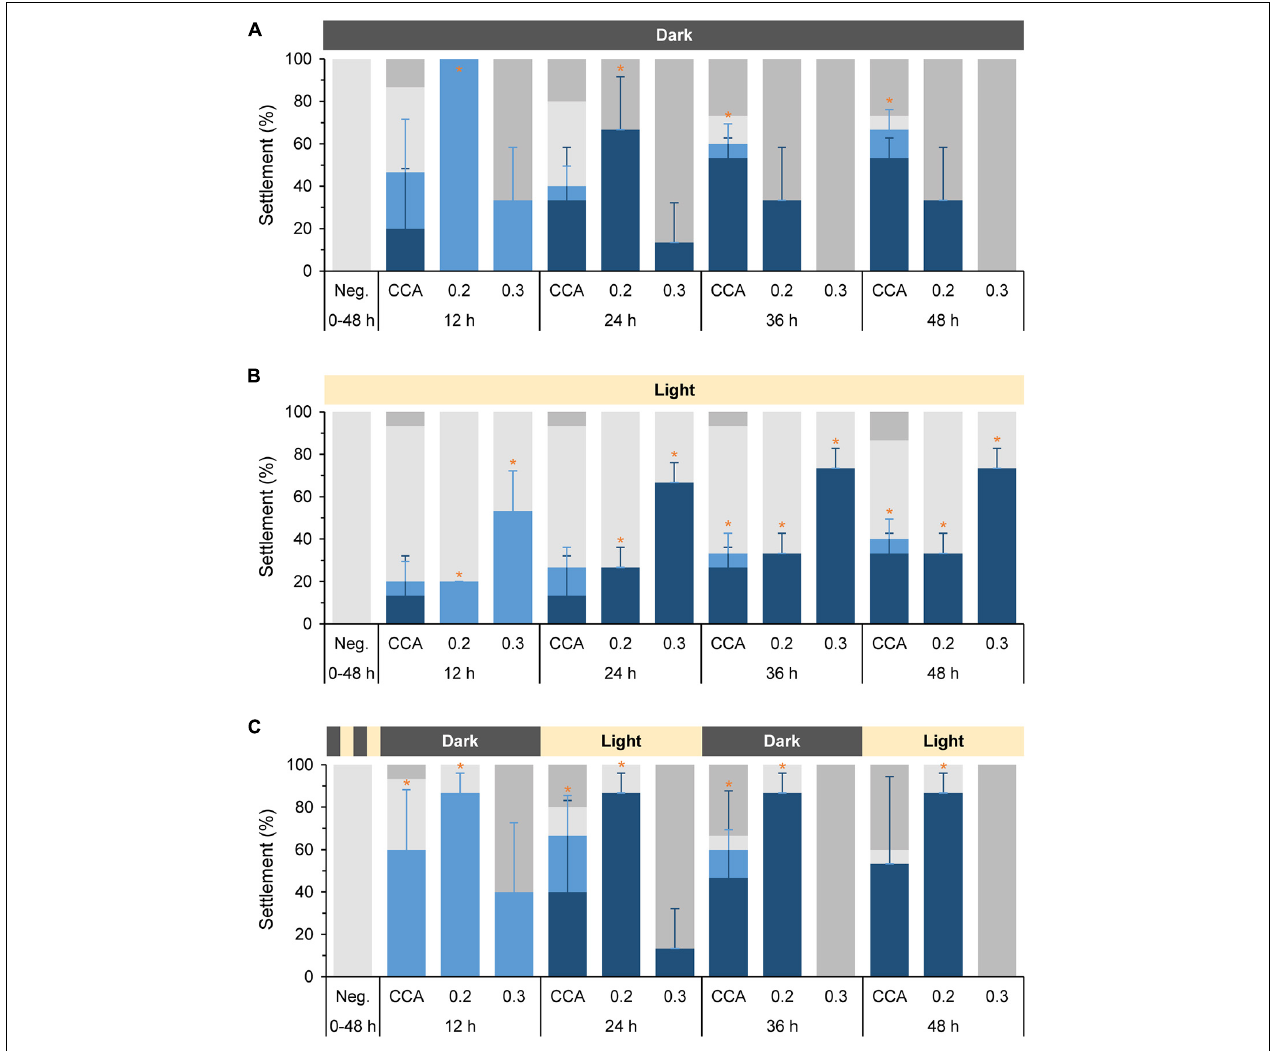
FIGURE 3 | Settlement behavior of Leptastrea purpurea larvae in response to different concentrations of cycloprodigiosin (I) and three varying light regimes. Coral larvae were exposed to (I) levels of 0.2 µ g mL − 1 and 0.3 µ g mL − 1 for 12, 24, 36, and 48 h in complete darkness (A) , constant white light (B) and 12 h alternating periods of dark and light phases starting with complete darkness (C) . Percentages of swimming larvae are displayed in light gray, attachment in light blue, settlement (attachment and metamorphosis) in dark blue, and dead larvae in dark gray colors. Evaporated MeOH and 5 mL of FASW served as negative control (Neg). Small pieces of live CCA emerged in 5 mL of FASW were used as positive control. Error bars represent standard deviations of settlement and attachment. Asterisks (*) represent significant settlement responses ( p < 0.05, n =